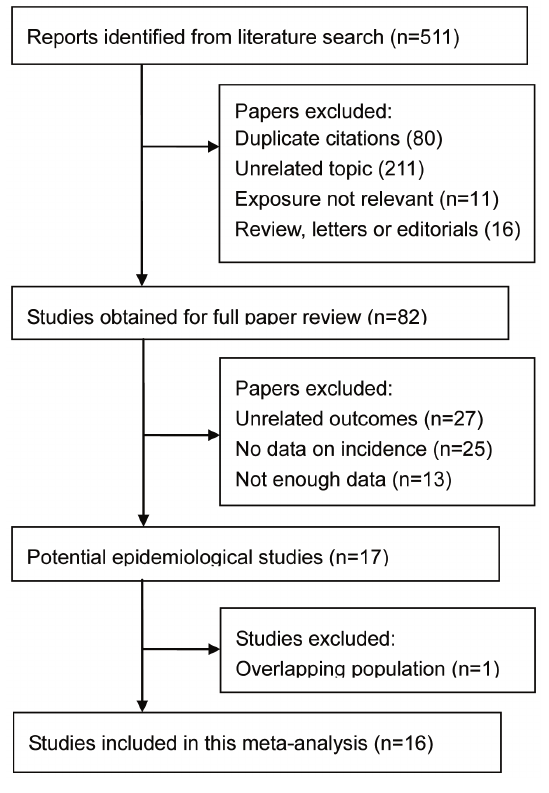
Figure 1. Diagram of study selection and inclusion.